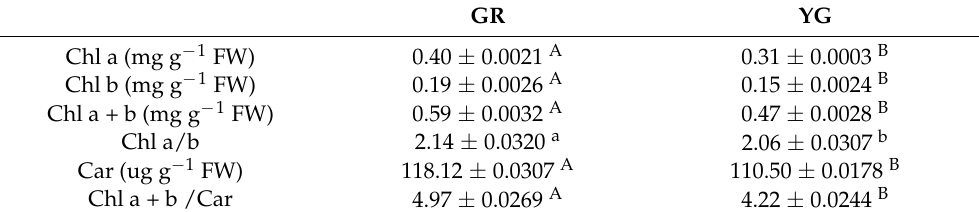
Table 3. Pigment contents in different parts of leaves of P. tatarinowii ‘Jinyuyuan’.